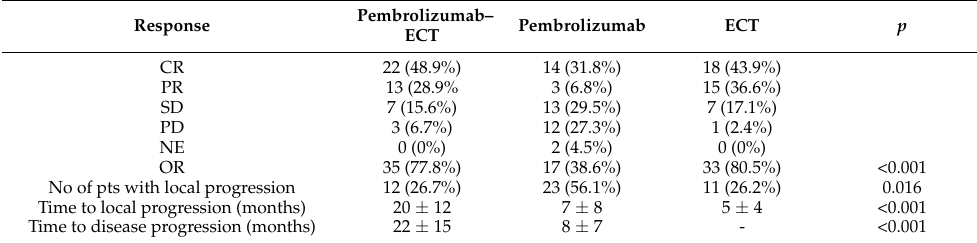
Table 3. Local response on skin metastases and disease control.